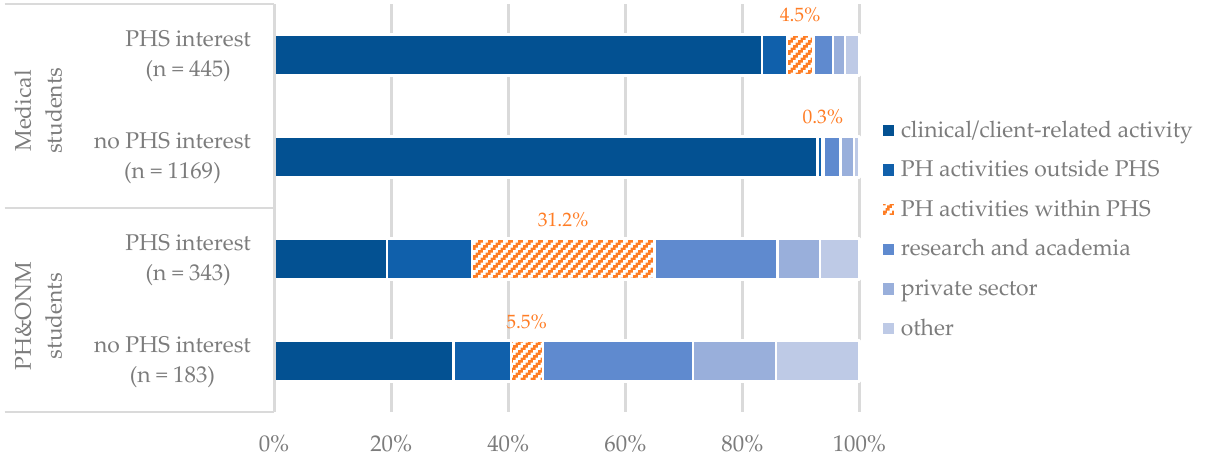
Figure 3. Preferred field of activity after graduation among medical ( n = 2058) and PH&ONM students ( n = 961) in Germany, according to their PHS interest in wave 1 of the OeGD-Studisurvey (The proportion of students who ranked a public health (PH) activity first is highlighted in orange).